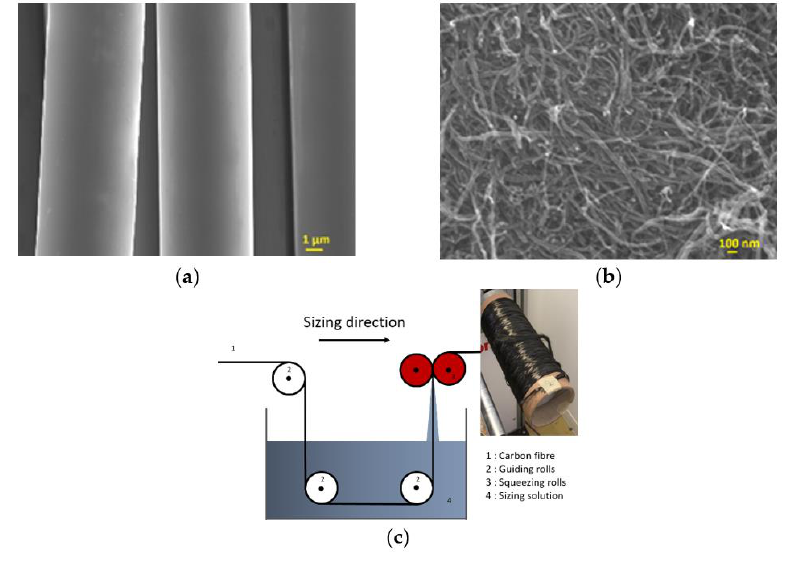
Figure 1. ( a ) T700 CFs, ( b ) CNFs and ( c ) the sizing process.